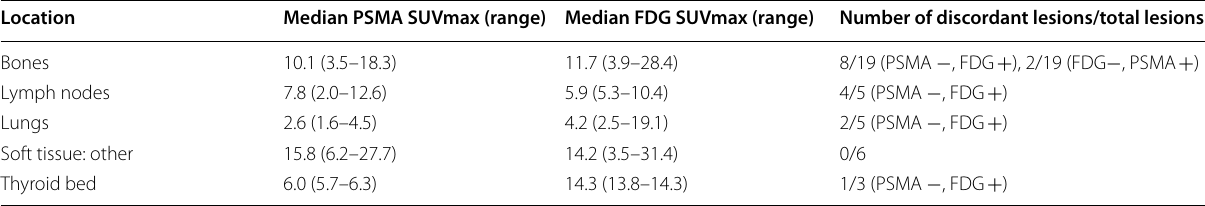
Table 3 Median lesion SUVmax and discordant lesions by location